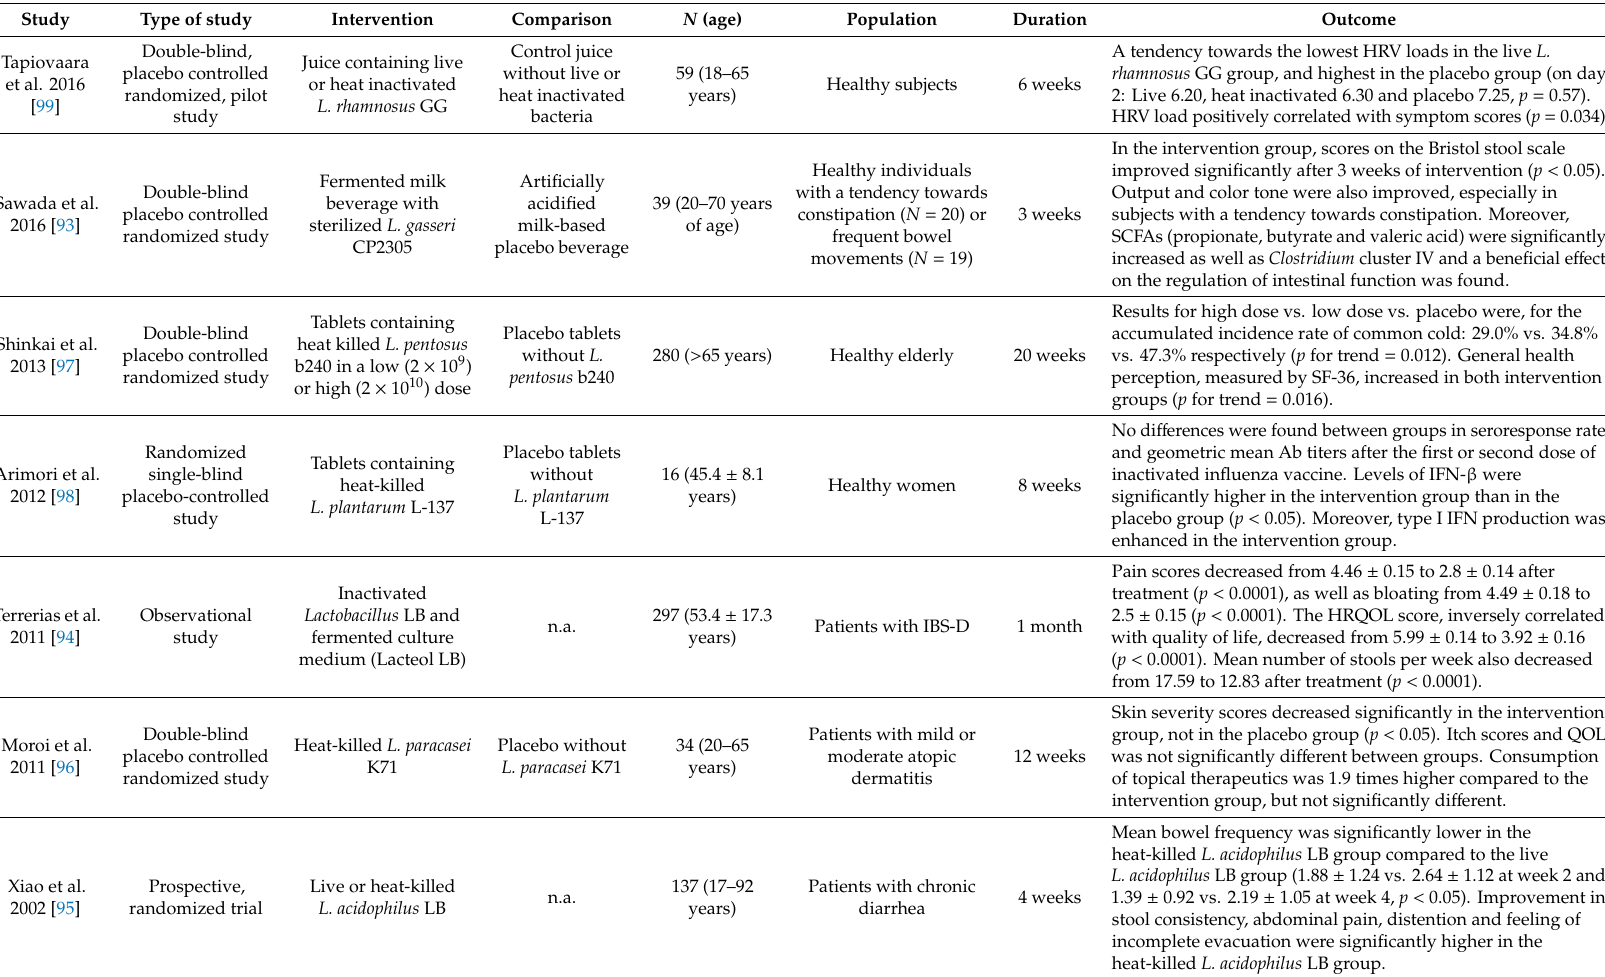
Table 2. Studies with postbiotics later in life, including adults and elderly ( > 18